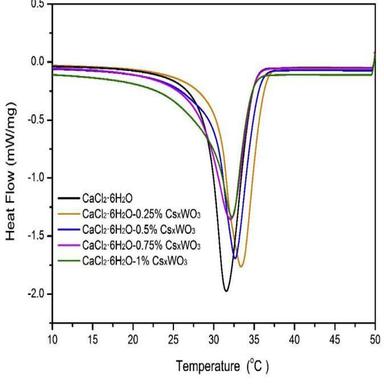
DSC curves of CaCl2·6H2O with different mass ratio of CsxWO3 nanoparticles.